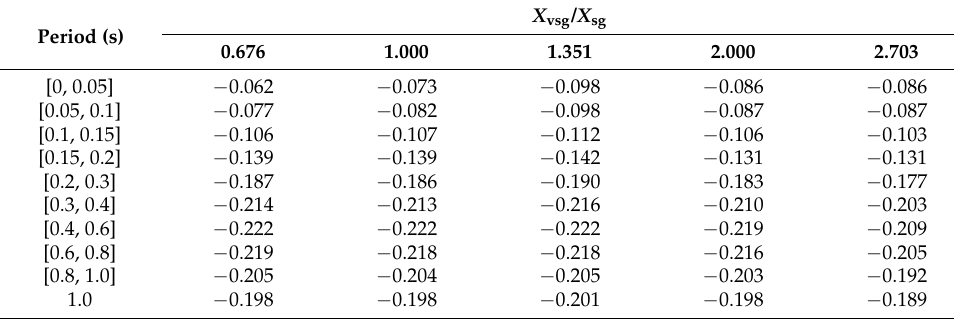
Table A2. Maximum frequency deviations (Hz) ( X vsg was changed).